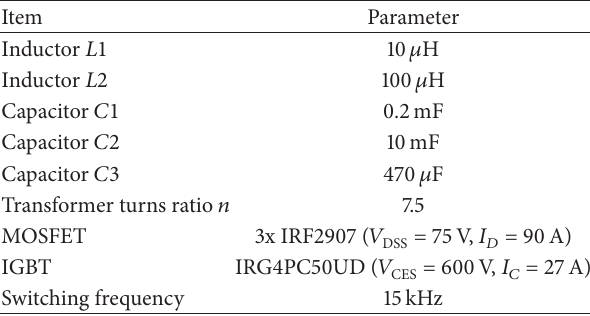
Table 1: Converter main electrical components.